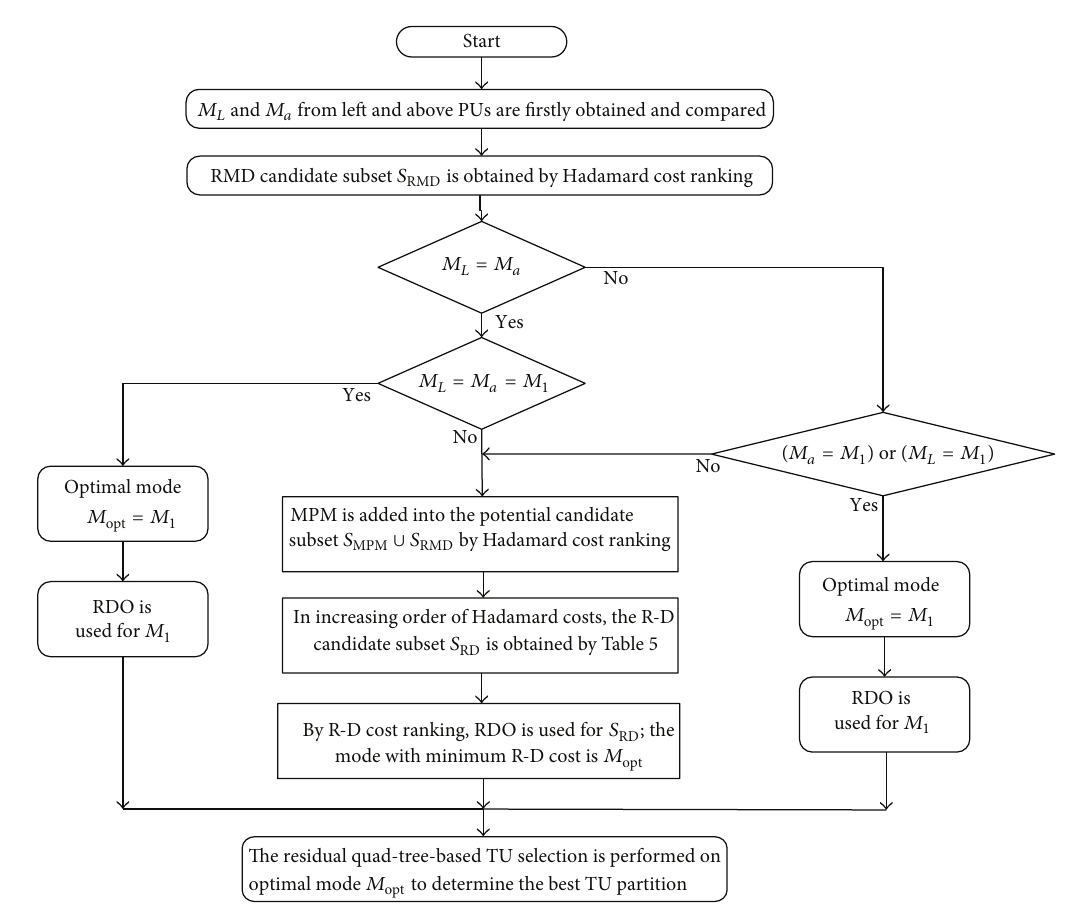
Figure 5: The flowchart of the proposed algorithm.